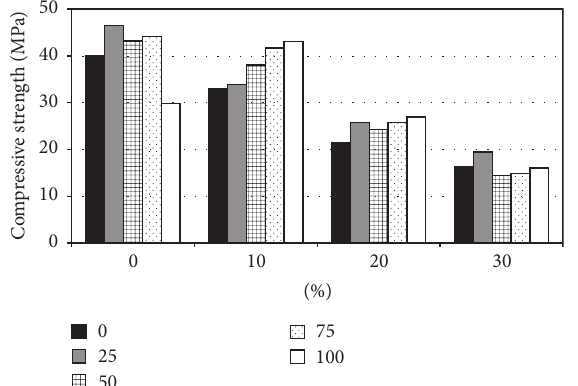
Figure 9: Compressive strength of mortars with FA-IW subjected to freezing cycles.